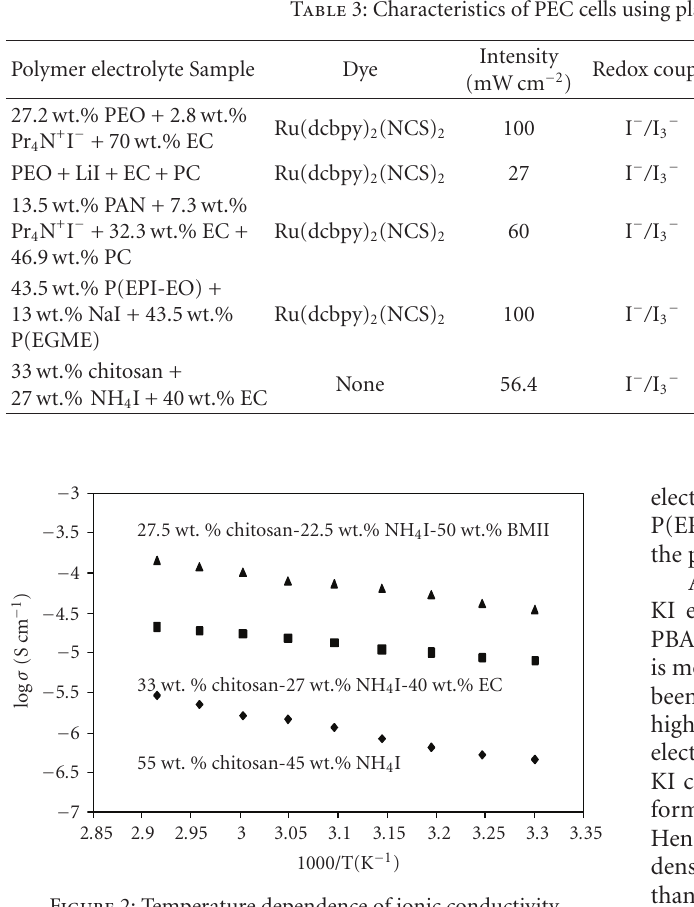
Figure 2: Temperature dependence of ionic conductivity.